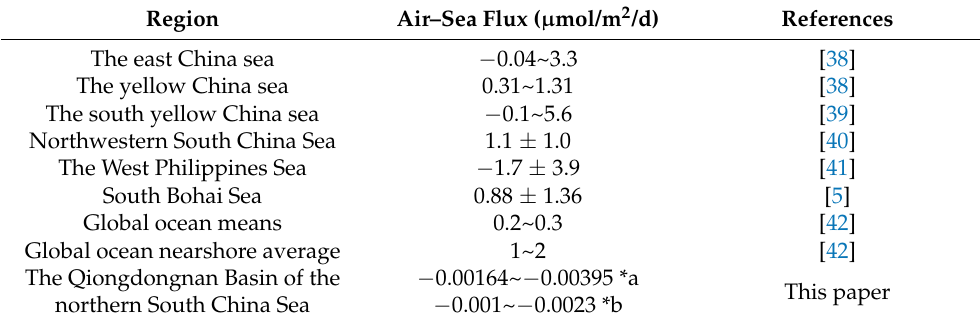
Table 3. Exchange fluxes of methane in different sea